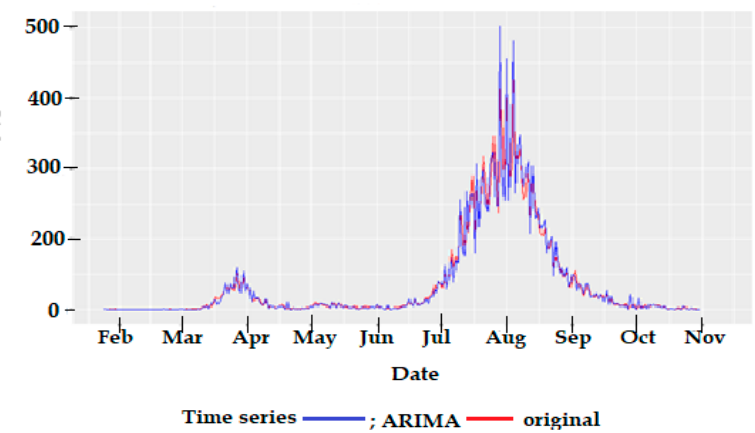
Figure 4. Comparison of the confirmed number of cases with the predictions from the auto-regressive integrated moving average (2,1,2) model. Table 3. Optimal ARIMA (2,1,2) model for stationary confirmed cases.